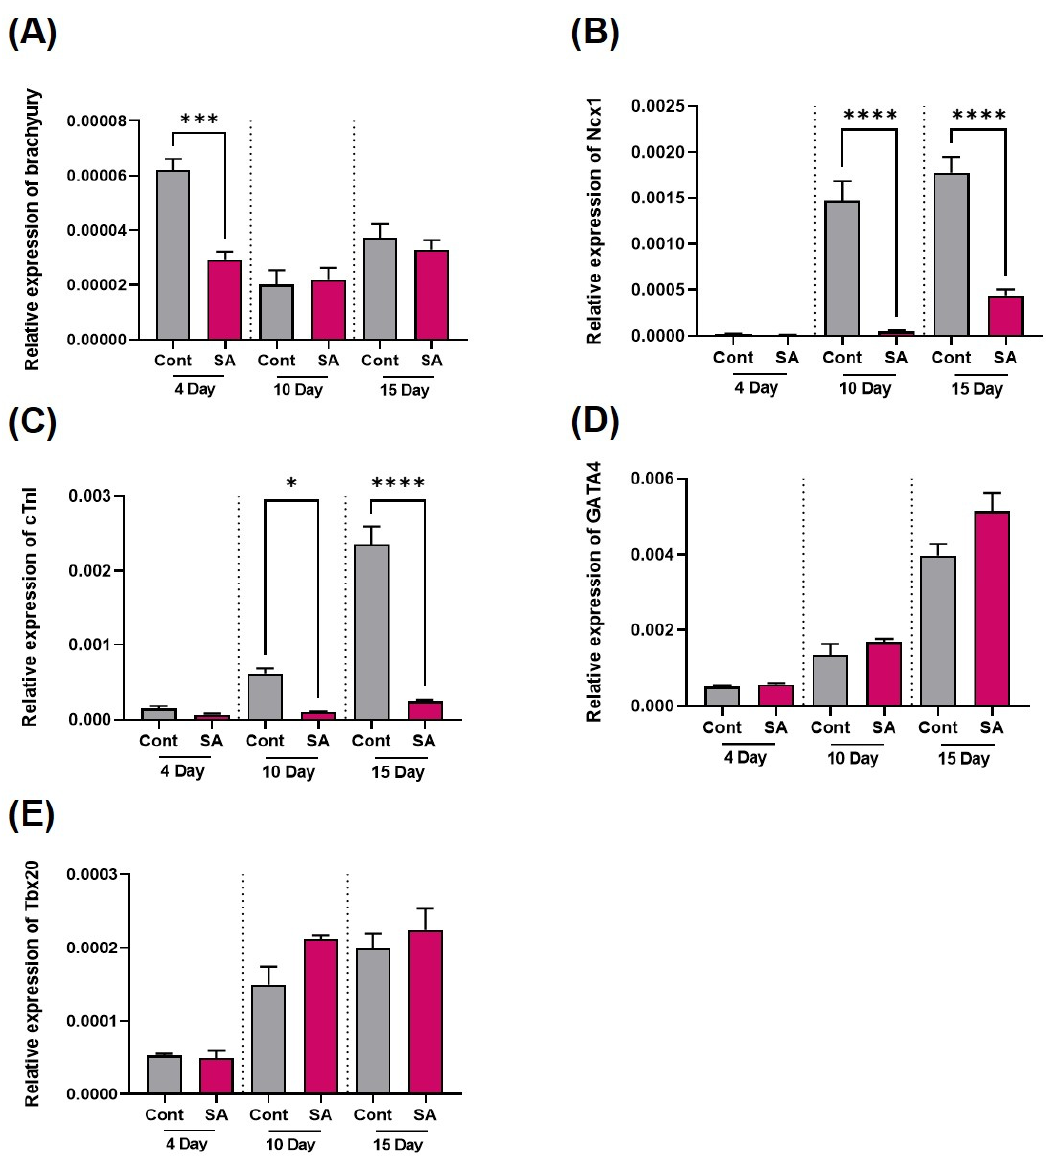
Figure 2. Effects of sodium arsenite on myocardial differentiation-related gene expression. Cardiac marker gene expression was measured on the 4th, 10th, and 15th days after SA treatment by real-time PCR in differentiation-induced EB to cardiomyocytes. ( A–E ) Bar graphs of gene transcription level, ( A ) Brachyury gene ( Bra ); ( B ) Ncx1 gene; ( C ) Cardiac troponin I (cTnI) gene; ( D ) Gata4 gene, and ( E ) Tbx20 gene. The significance was obtained by ANOVA. * p < 0.05 and *** p < 0.001, **** p < 0.0001 vs. control. Each value is expressed as means ± SD. n = 3 in three independent experiments. Cont; control, SA; sodium arsenite.